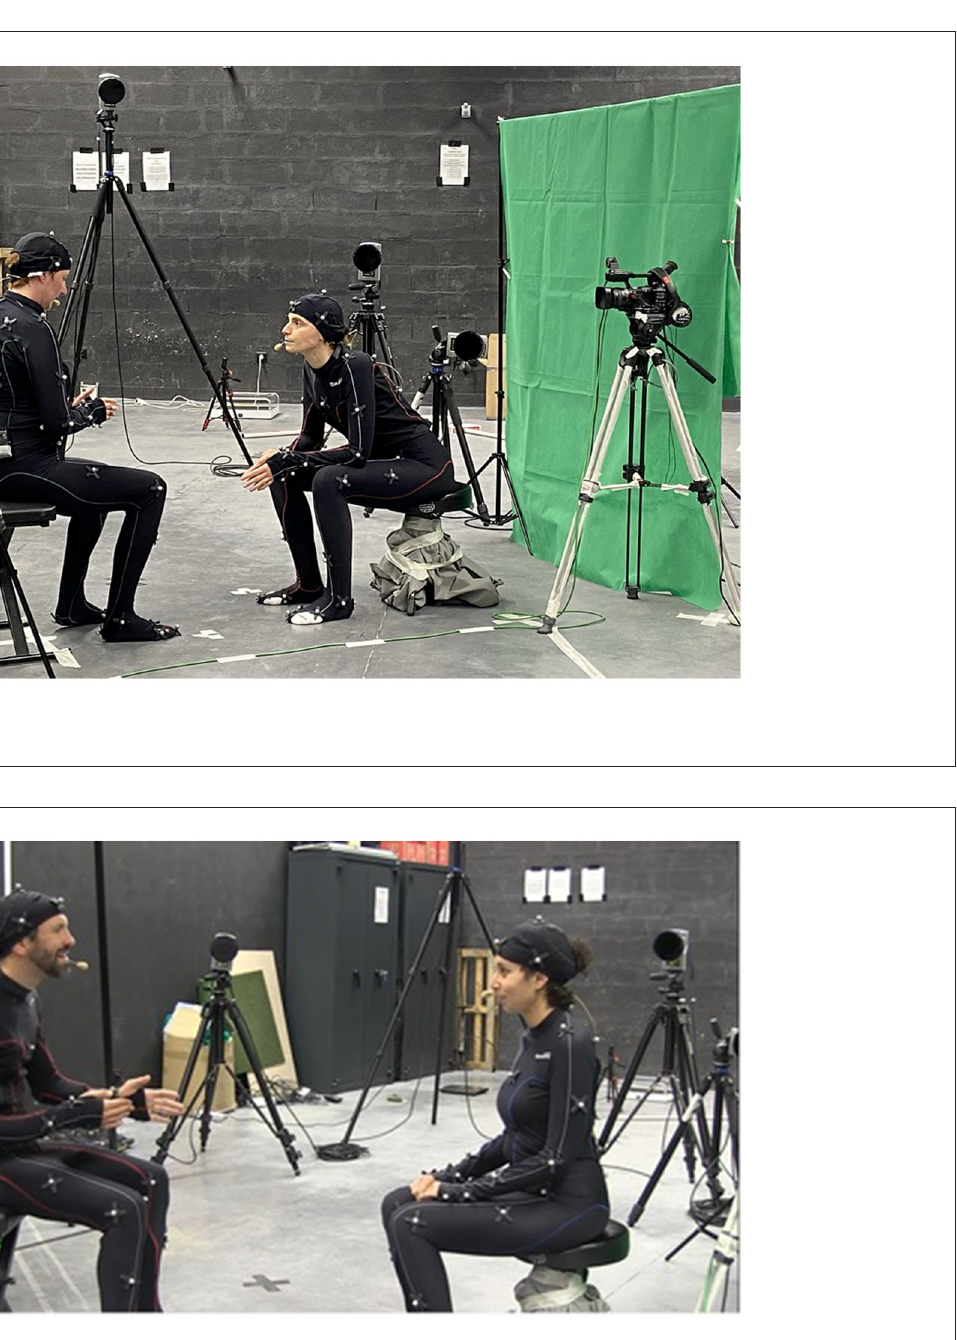
FIGURE3 Face-to-face conversation recording with the camera